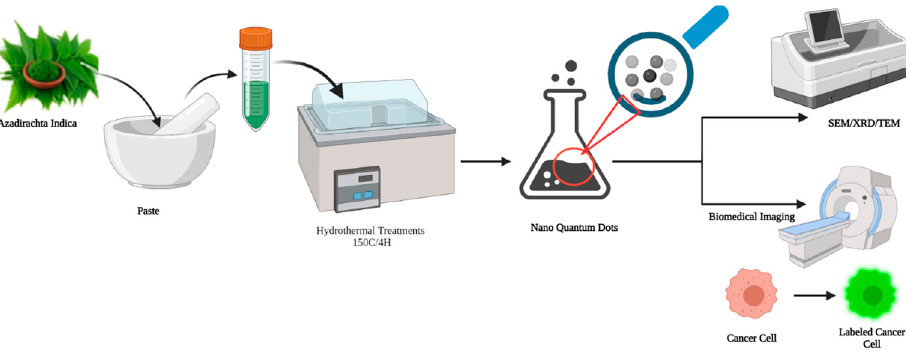
Figure 4. One-pot hydrothermal based green synthesis of nano-CQDs.